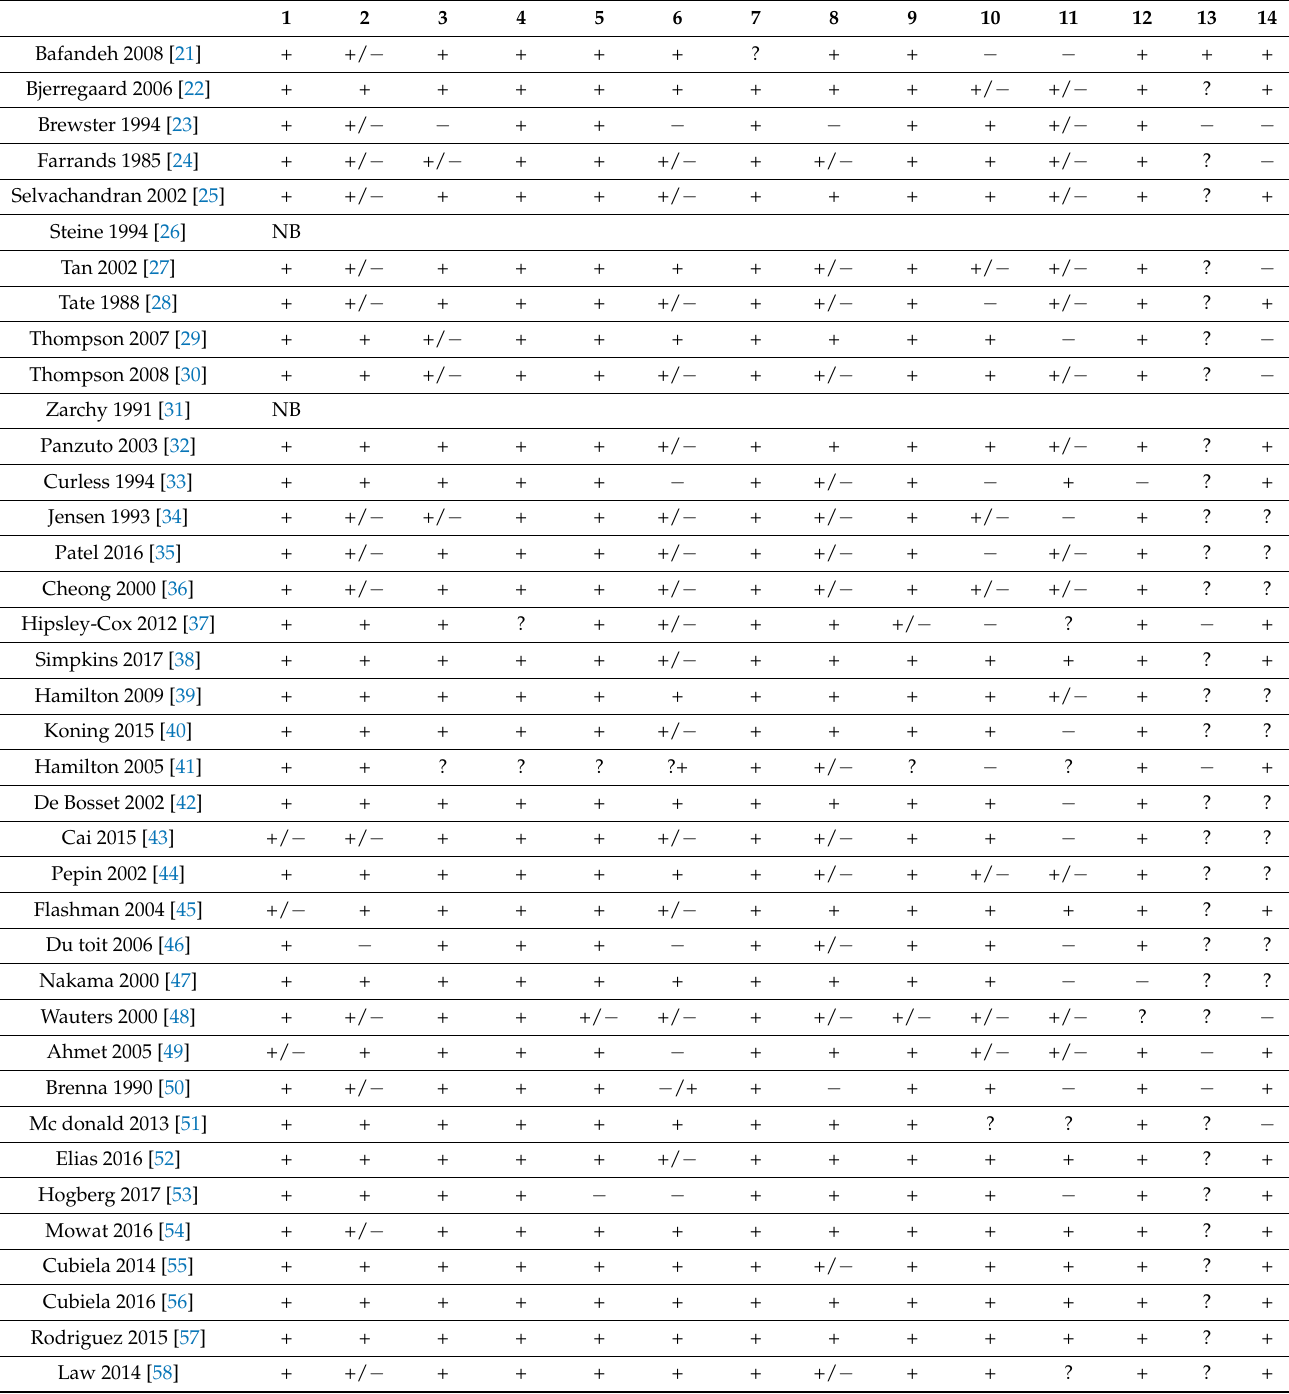
Table 1. The QUADAS